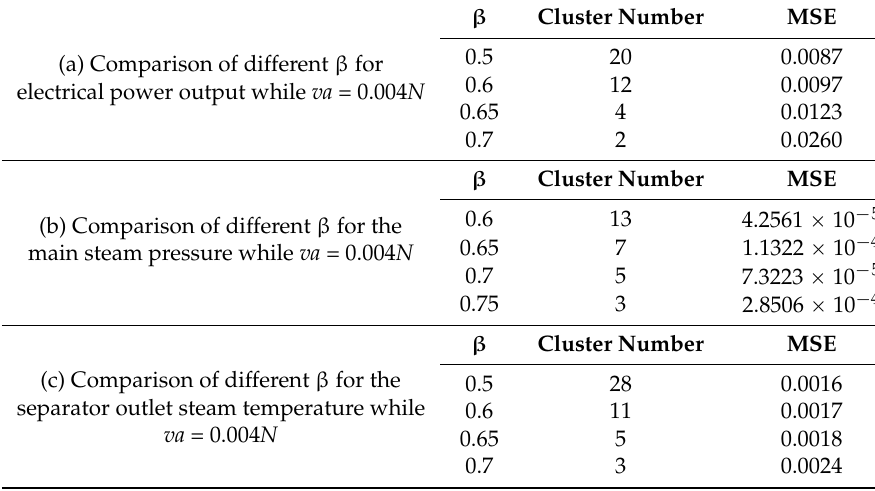
Table 1. Comparison of different β for different objects while va remains unchanged.